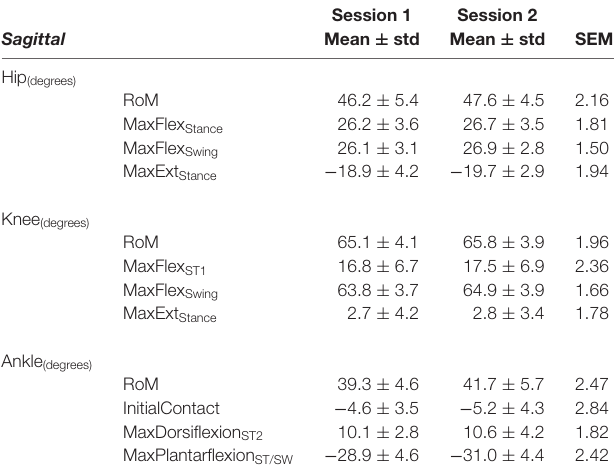
TABLE 3 | Sagittal plane variables—Self-Selected Walking Speed: mean ± standard deviation (std) for Session 1 and Session 2, and Standard Error of Measurement